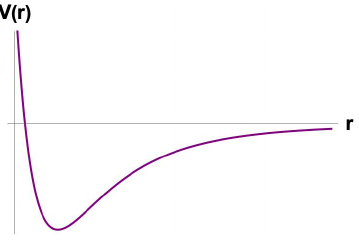
Figure 5: Effective